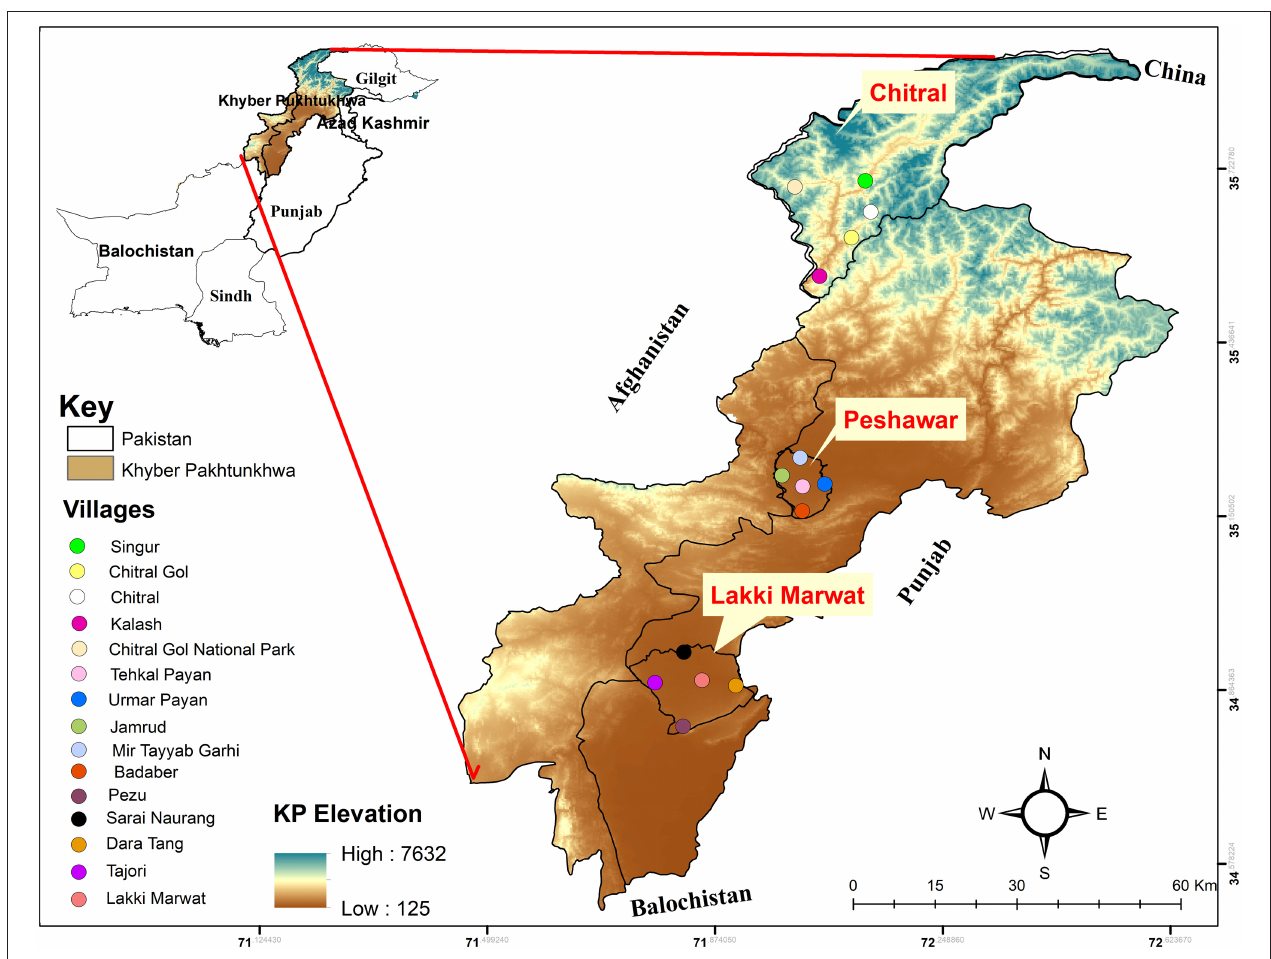
FIGURE 1 | Elevation map showing the study area where Argas ticks were